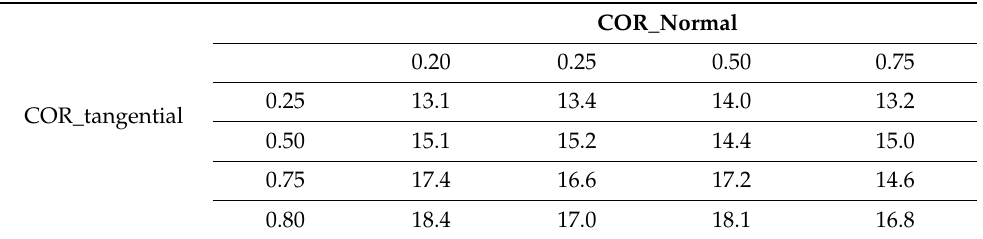
Table 2. Total particle deposition (%) in the inhaler for different combinations of tangential and normal COR values.